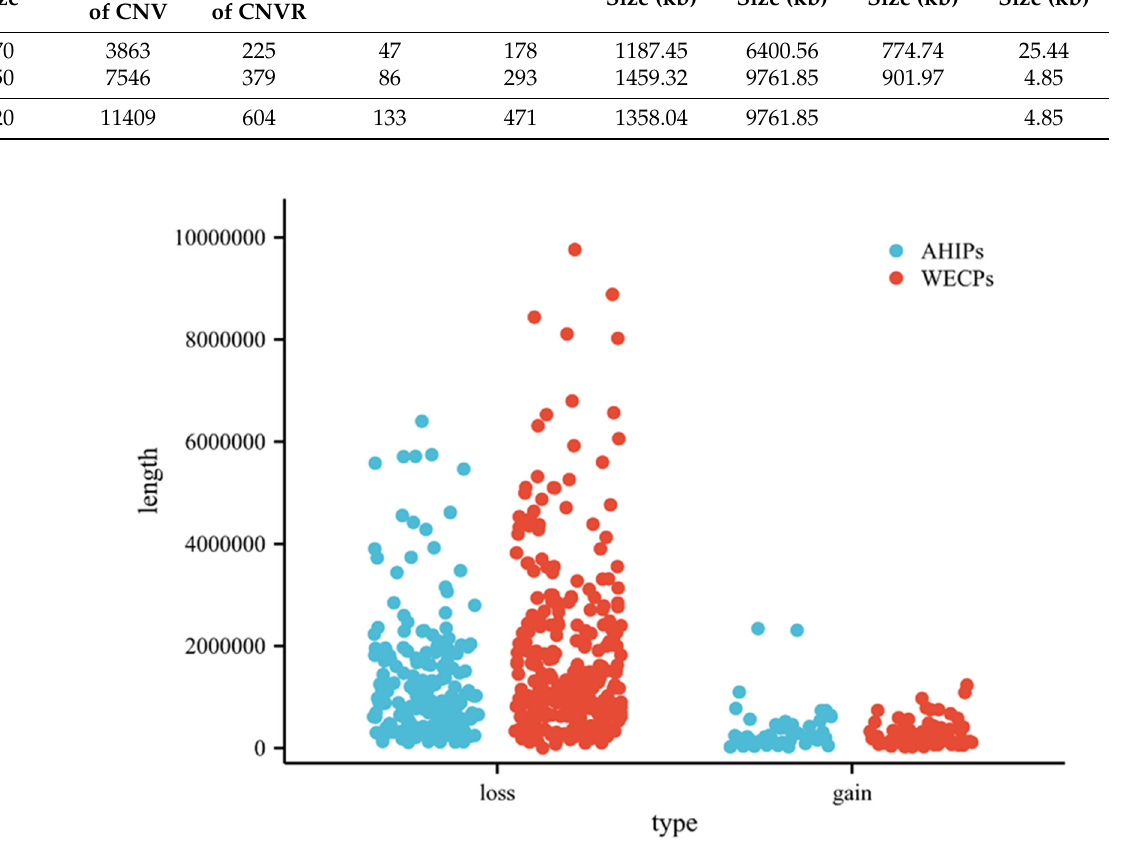
Figure 3. Different CNVR events and length statistics in the AHIP and WECP populations. The X - axis represents the type of CNVR in the AHIP and WECP populations, and the Y -axis is the length size of the CNVR. Violin width is wider representing more data and narrower representing less data.